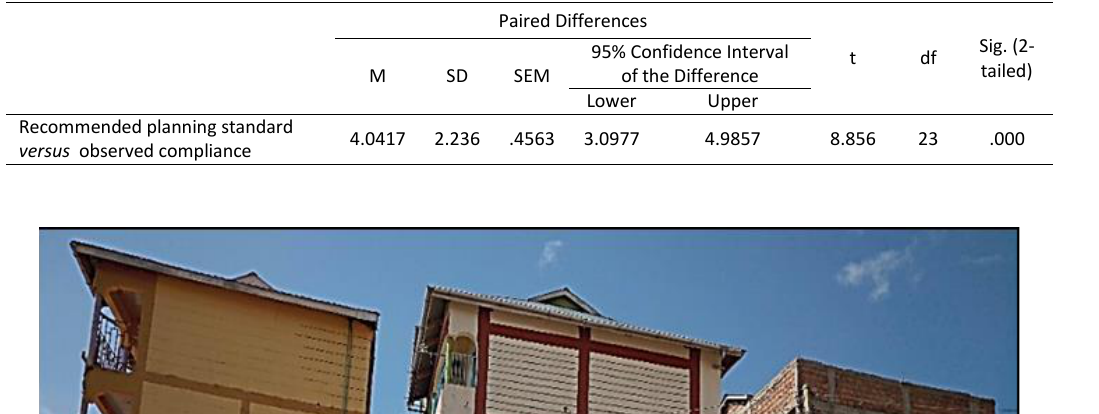
Table 2: Paired samples for parking standards in Nyanchwa